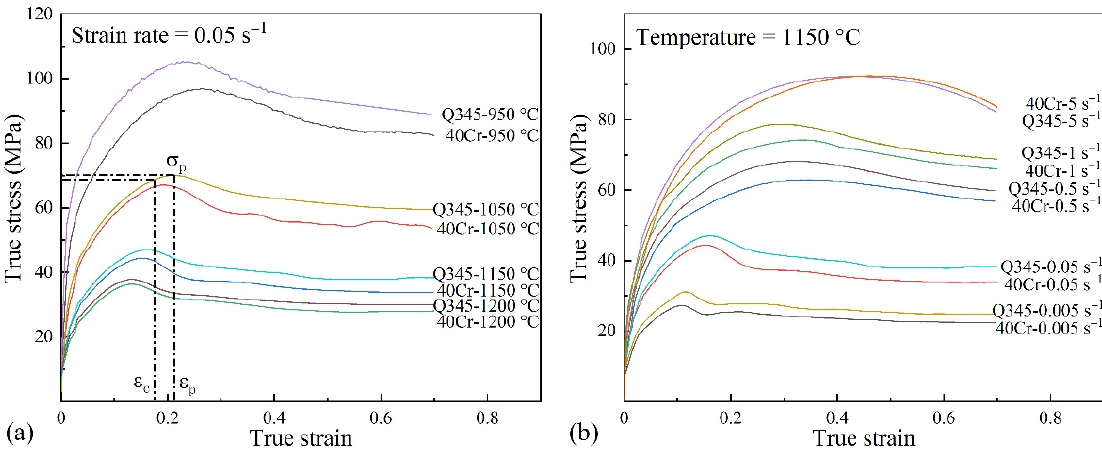
Figure 5. The flow stress curves of two steels with strain rates of 0.05 s − 1 ( a ) and temperature of 1150 °C ( b ).